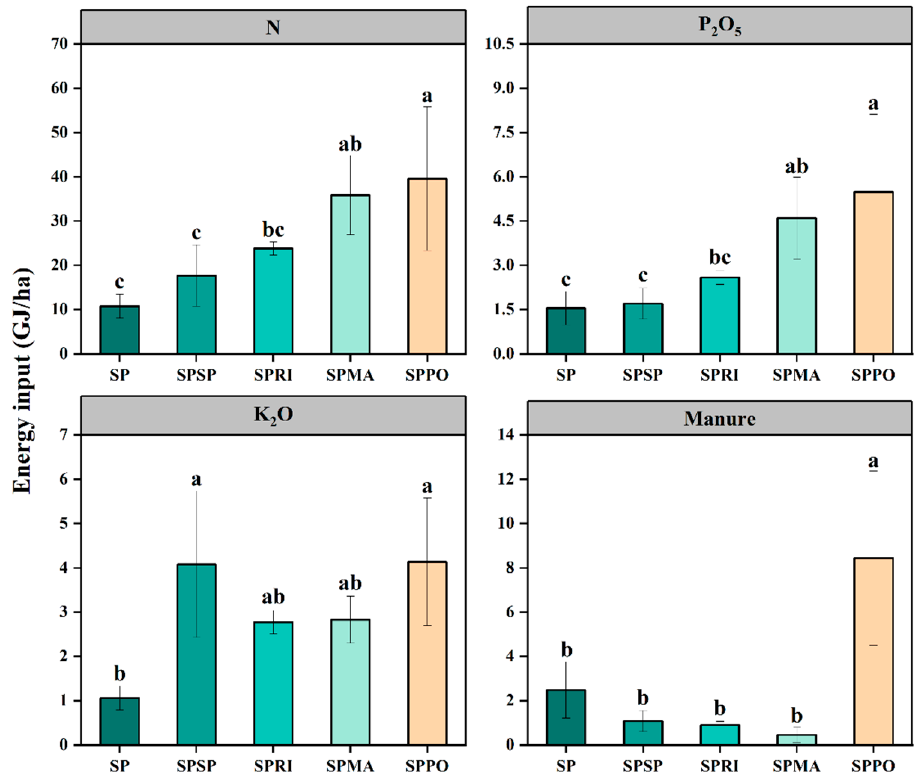
Figure 5. Energy inputs of nitrogen (N), phosphorus (P 2 O 5 ), potassium (K 2 O), and farmyard manure of mono cropping of sweet potato (SP); continuous cropping of sweet potato (SPSP); and rotation cropping system of sweet potato–rice (SPRI), sweet potato–maize (SPMA), and sweet potato–potato (SPPO). The different lowercase letters indicate significant differences within cropping system treat- ments at p < 0.05. Bars represent standard